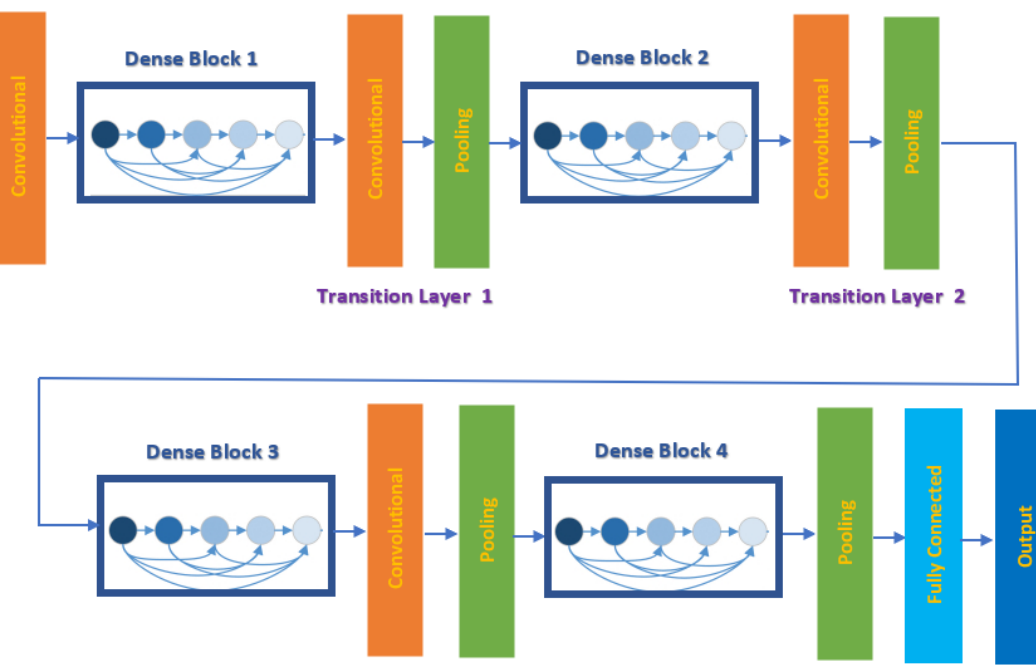
Figure 3. The architecture of DenseNet-201 CNN. Table 3. The dimensions of the various layers of DenseNet-201 CNN. Layer Label